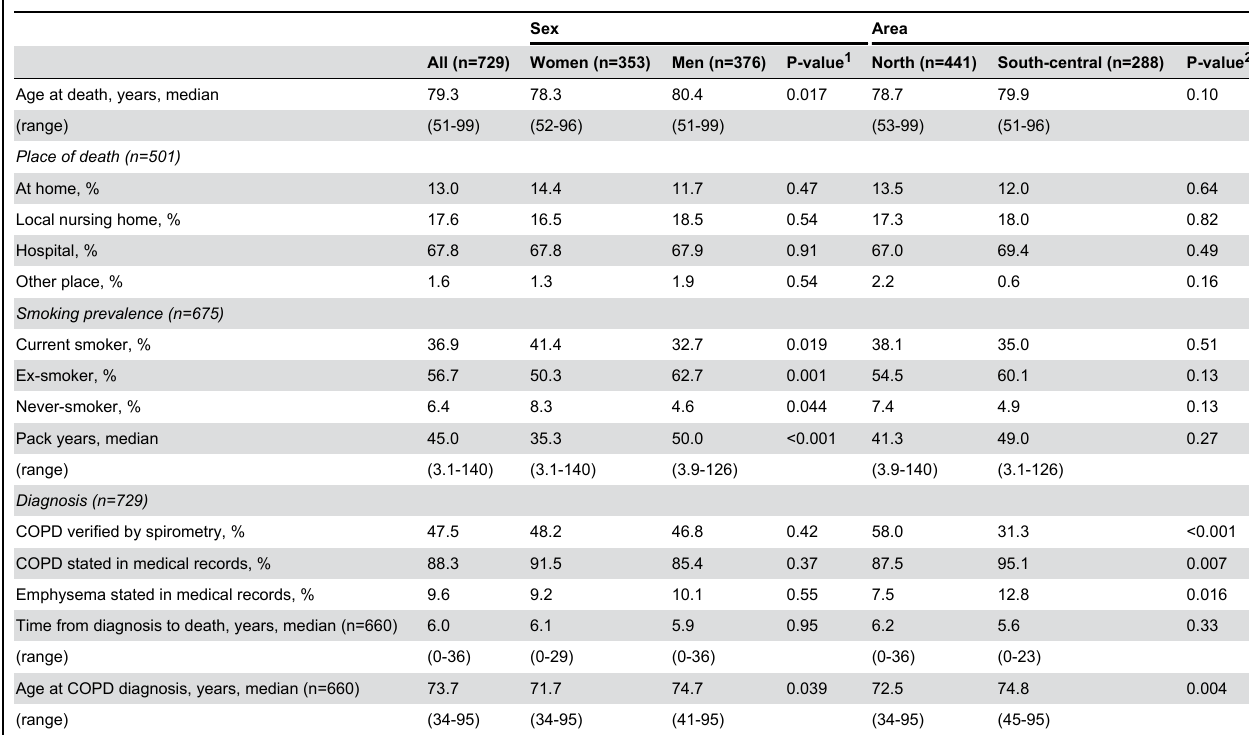
Table 2. Patient characteristics.